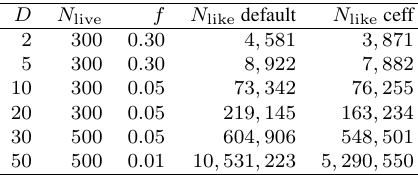
TABLE 1 D IMENSIONALITY ( D ) OF PROBLEM , NUMBER OF LIVE POINTS ( N live ), TARGET EFFICIENCY ( f ) AND THE TOTAL NUMBER OF LIKELIHOOD EVALUATIONS ( N like ) IN DEFAULT AND CONSTANT EFFICIENCY ( CEFF ) MODES OF M ULTI N EST FOR TEST PROBLEM 1, DISCUSSED IN S EC .